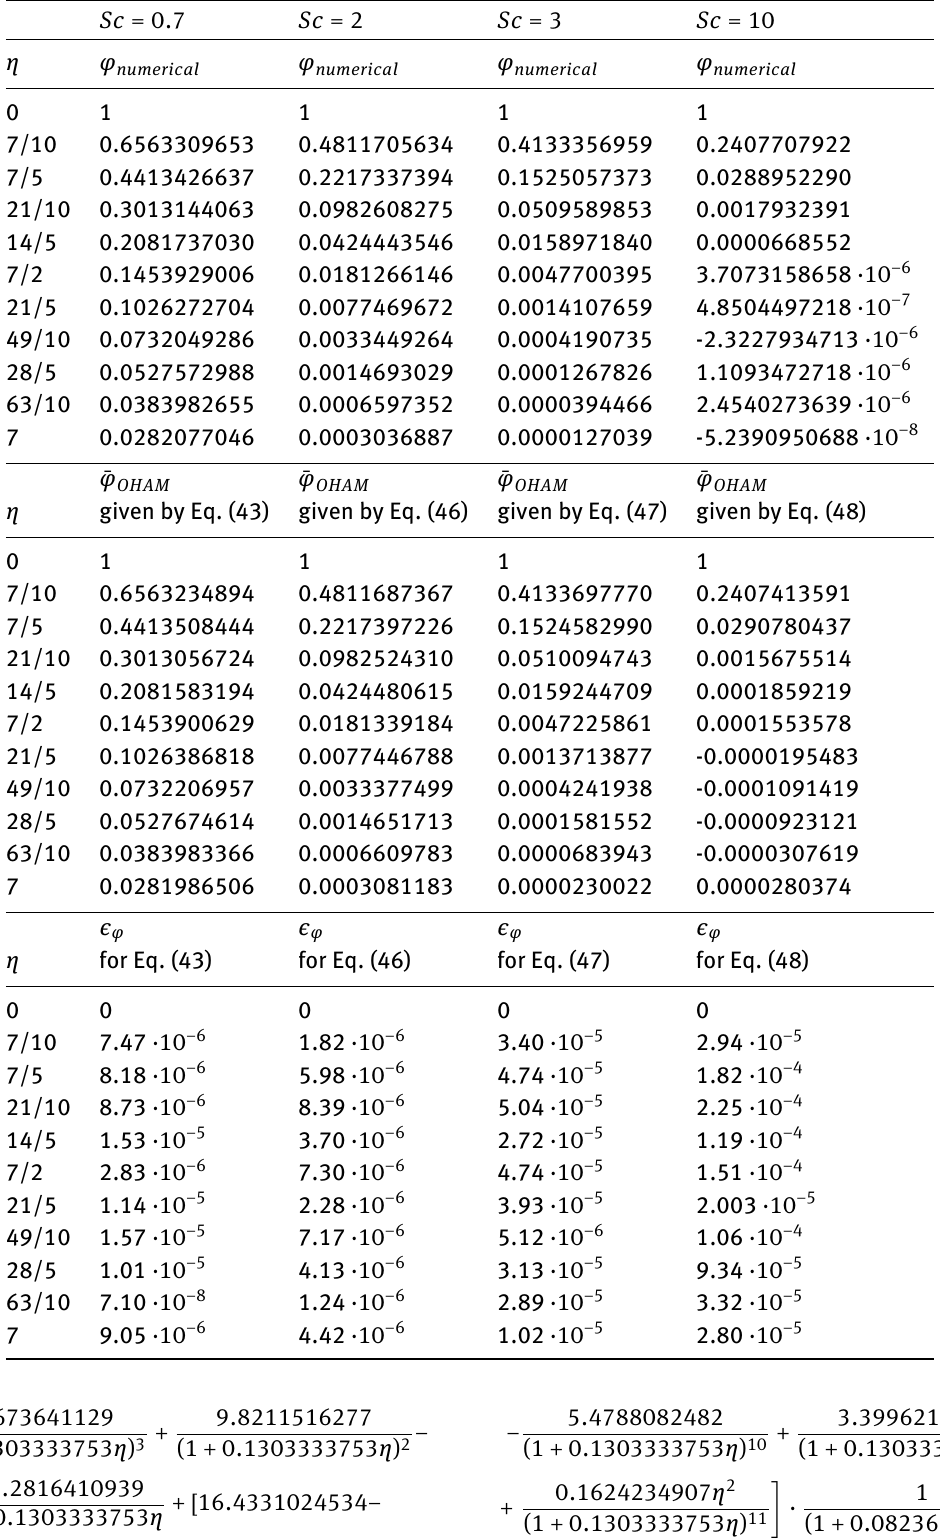
Table 5: Comparison between the approximate solutions φ given by Eqs. (43), (46), (47), (48) and numerical results for λ = 0.1 , S = −0.5 , β = 0.1 and different values of the Schmidt parameter Sc (relative errors: ϵ φ = | φ numerical − ¯ φ OHAM |